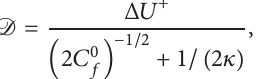
Figure 4: The variation of DR in the downstream direction. (Black, solid) DR from DNS. (Red, broken) DR from (18). (Green, broken) DR from (17). (Blue, broken) DR from (26). (Blue, solid) DR from (26) with Δ𝑈 + from expression (29) ( Δ𝑈 + = 2.25 ). (Cyan, solid) DR from expression